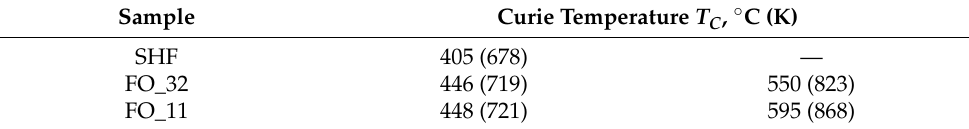
Table 3. Magnetic properties of the uncovered SrFe 10 Cr 2 O 19 (SHF) nanoparticles and composite samples (FO_32 and FO_11) at different temperatures. H C represents coercivity, M S —sample magne- tization at 30 kOe, M R —remanent